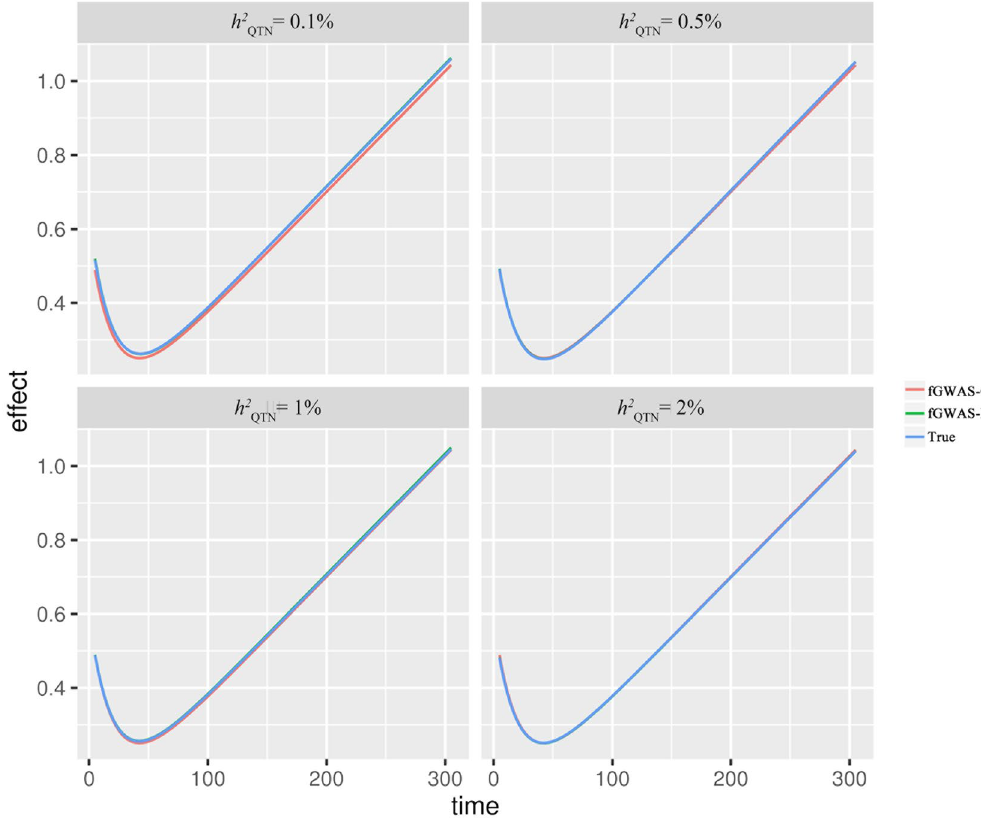
Figure 4. The plots of average additive genetic effect curves predicted by the fGWAS-C and fGWAS-F models against the simulated true curves with alternative QTN heritabilities for the simulation study.